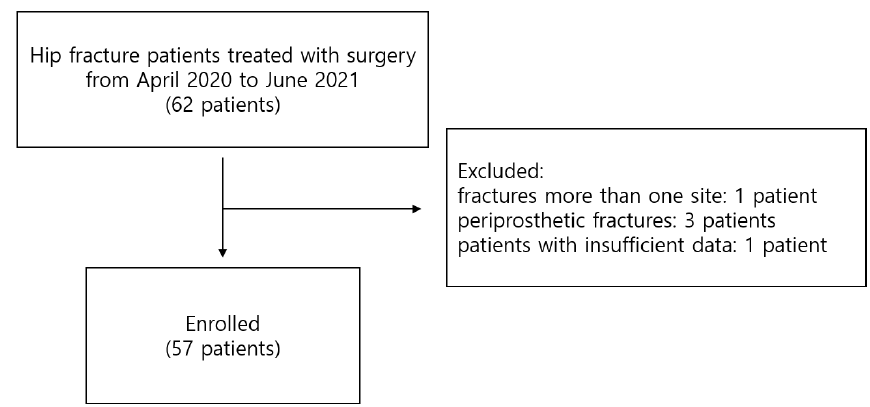
Figure 1. Flowchart of patients enrolled in this study.